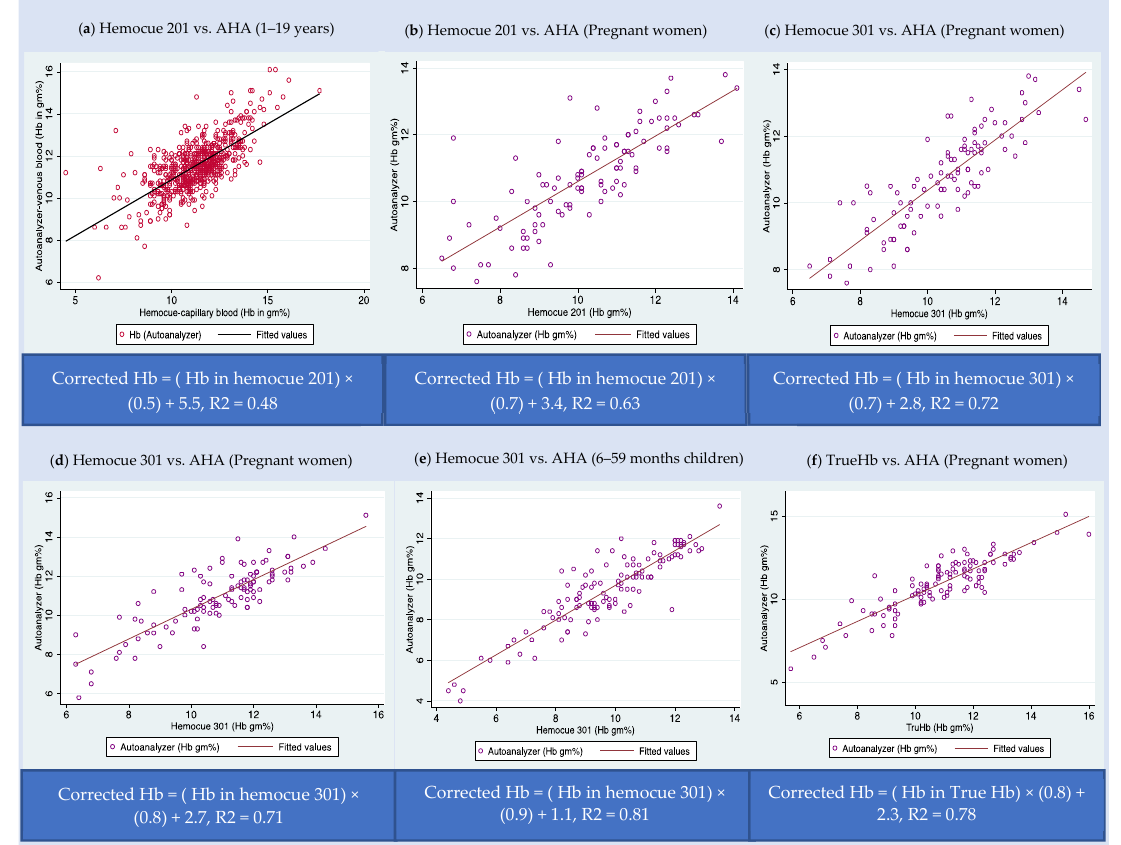
Figure 1. Scatter plot of hemoglobin estimated point-of-care tests (POCT) vs. automated hematology analyzers (AHA) based on the data subsets from India. ( a ) Hemocue 201 (POCT) vs. AHA among 1–19-year-old children—dataset D; ( b ) Hemocue 201 (POCT) vs. AHA among pregnant women— dataset A; ( c ) Hemocue 301 (POCT) vs. AHA among pregnant women– dataset A; ( d ) Hemocue 301 (POCT) vs. AHA among pregnant women—dataset B; ( e ) Hemocue 301 (POCT) vs. AHA among 6–59-month-old children—dataset C; and ( f ) TrueHb hemometer (POCT) vs. AHA among pregnant women—dataset B. Figure 2 shows the error graph of the residual plots, where the residual errors are plotted against the predicted hemoglobin values. We observed some patterns in the residual graphical or significant values in the Breusch–Pagan test. Hence, we used hetrodescadacity random standard errors in the regression.